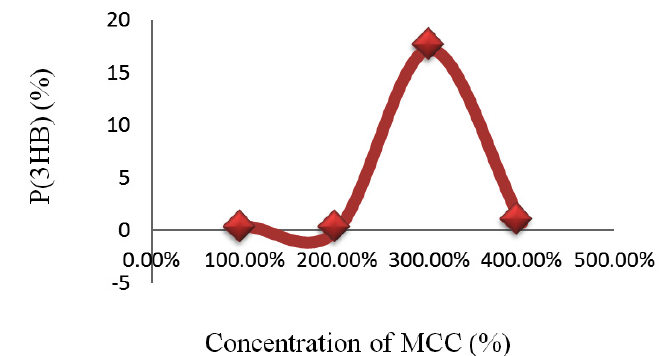
Fig. 2. The relationship between the percentage of P(3HB) accumulated in Psedomonas aeroginasa cell content versus concentration of MCC obtained from rice straw